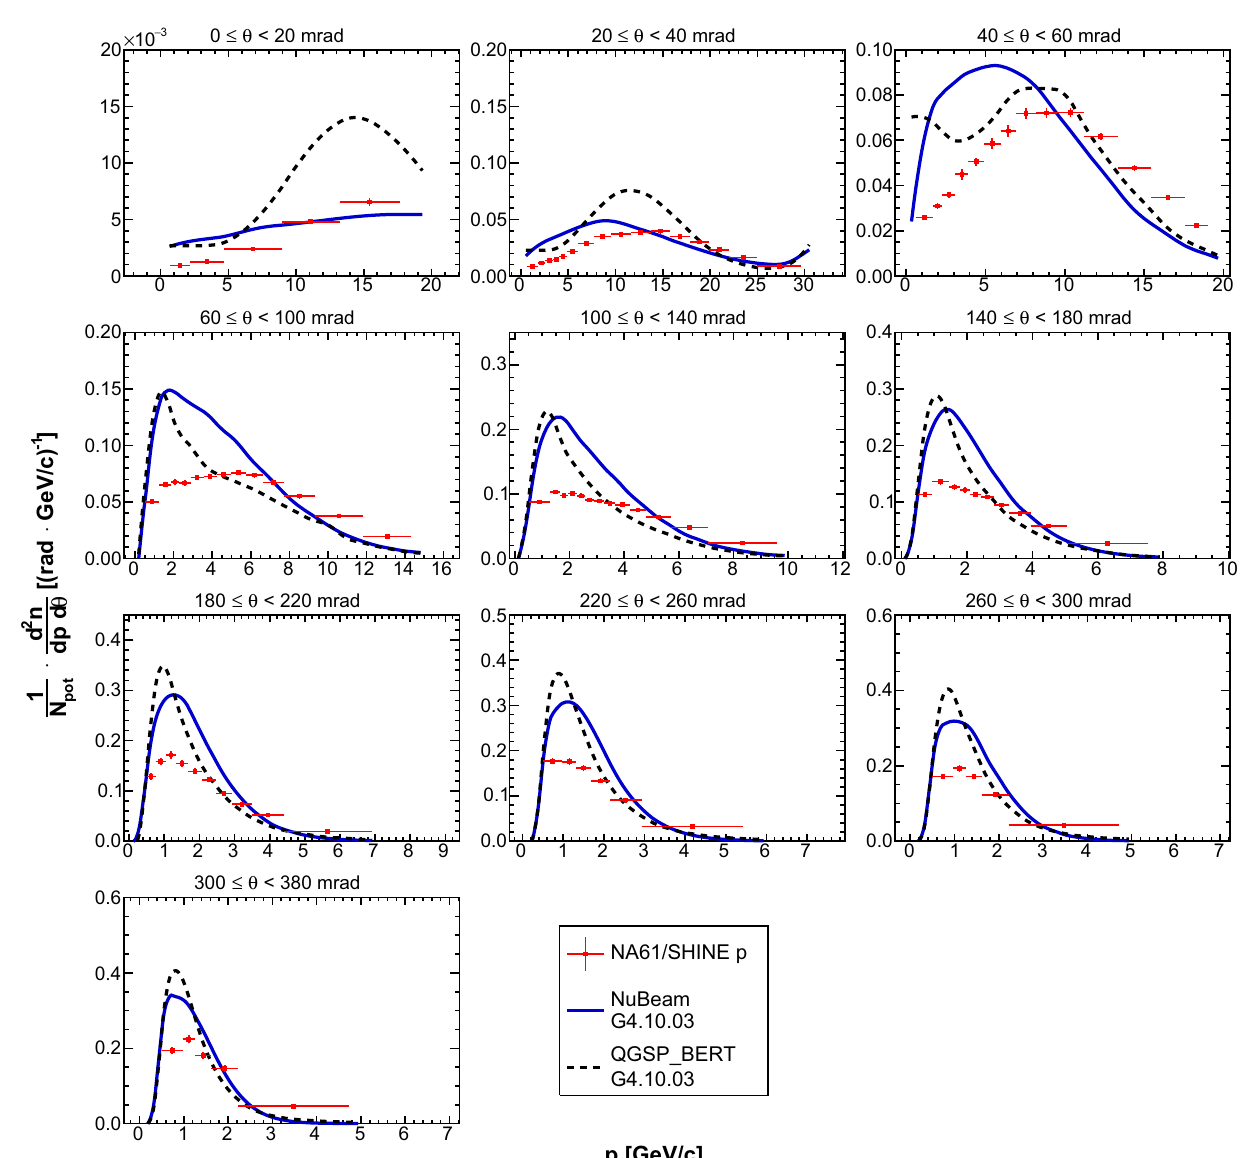
Fig. 49 Double differential yields of protons kaons for the third upstream longitudinal bin (36 ≤ z < 54 cm). Vertical bars represent the total uncertanties. Predictions from the NuBeam (solid blue line)